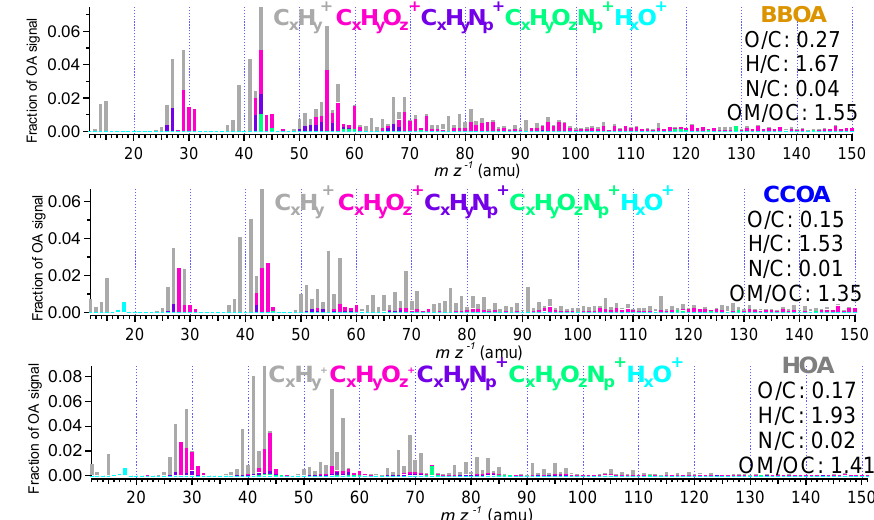
Figure 2. The anchor mass spectra for (a) BBOA, (b) CCOA and (c) HOA in the ME-2 analysis.